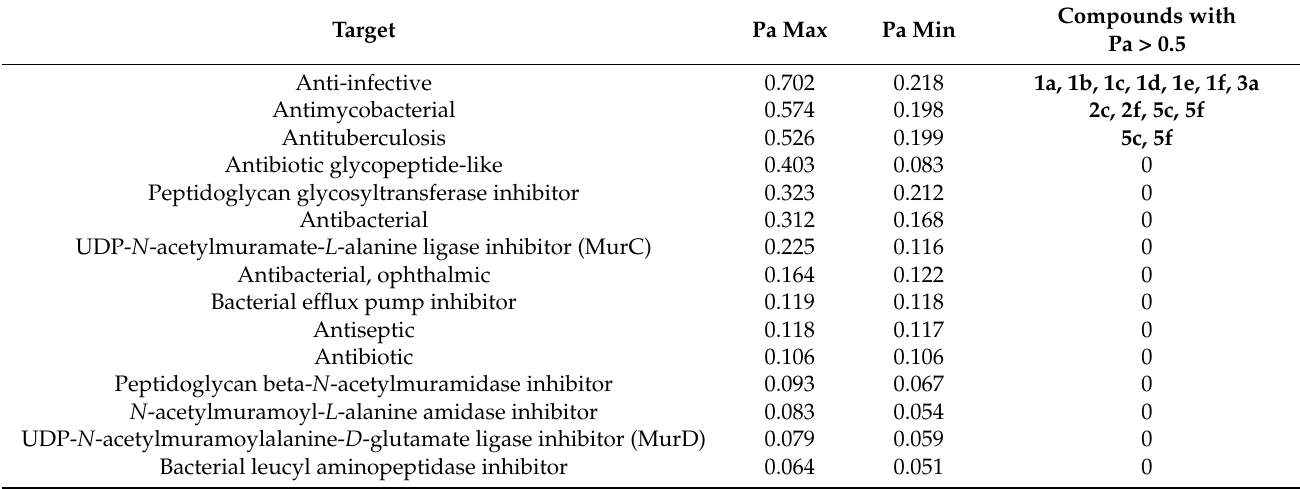
Table 3. The probability (Pa) for the compounds to produce biological effects related to antibacterial action as predicted by the PASS